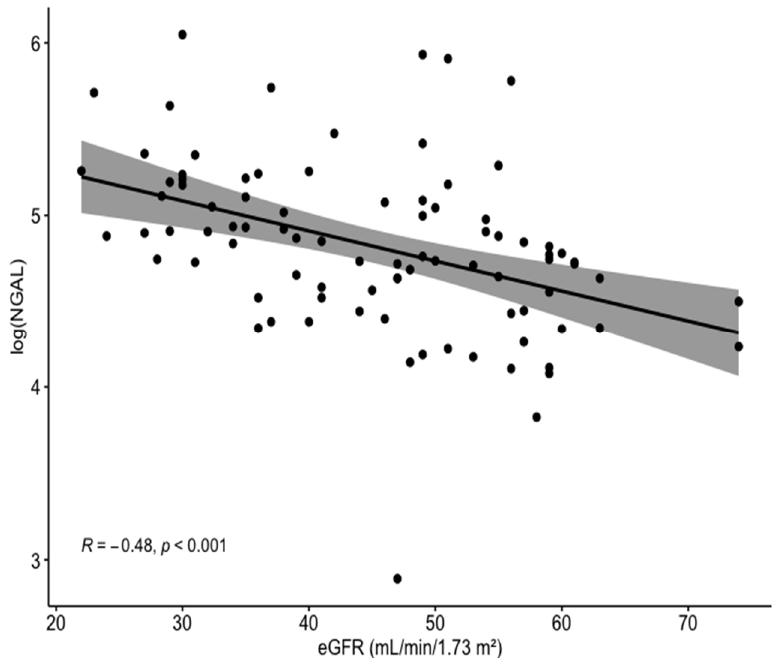
Figure 1. Correlation between the log of baseline serum NGAL levels and eGFR for the entire cohort. NGAL, neutrophil gelatinase-associated lipocalin; eGFR, estimated glomerular filtration rate. According to the ROC curve, baseline NGAL levels performed better than eGFR to predict CI-AKI (AUC 0.753 vs. 0.604) with the optimal cutoff value for baseline NGAL to predict CI-AKI being 127 ng/mL (sensitivity of 68% and specificity of 68%, p < 0.001) (Figure 2).